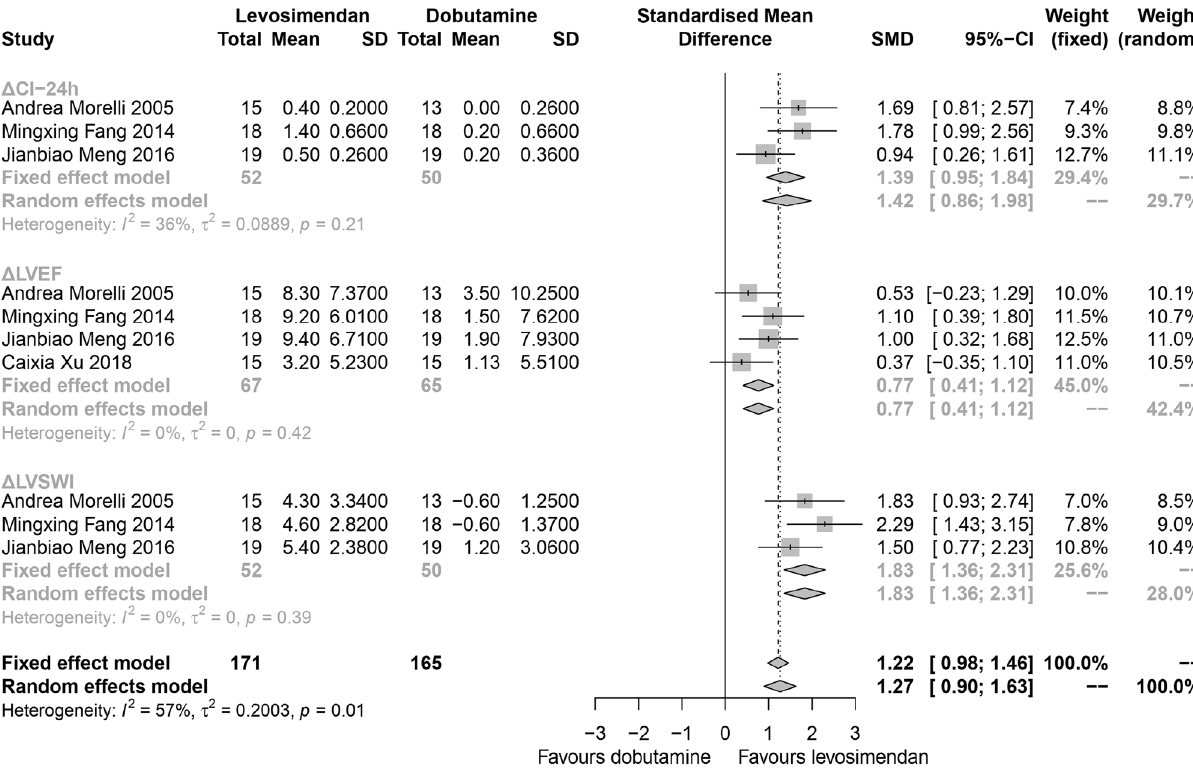
Figure 7. Change of cardiac function at the time point of 24-h after removing the studies from the corresponding groups. ΔCI-24 h: the change (before-after comparison to the baseline) of cardiac index at the time point of 24-h; ΔLVEF: the change (before-after comparison to the baseline) of left ventricular ejection fractions at the time point of 24-h; ΔLVSWI: the change (before-after comparison to the baseline) of left ventricular stroke work index at the time point of 24-h; SD standard deviation; MD mean difference; CI confidence